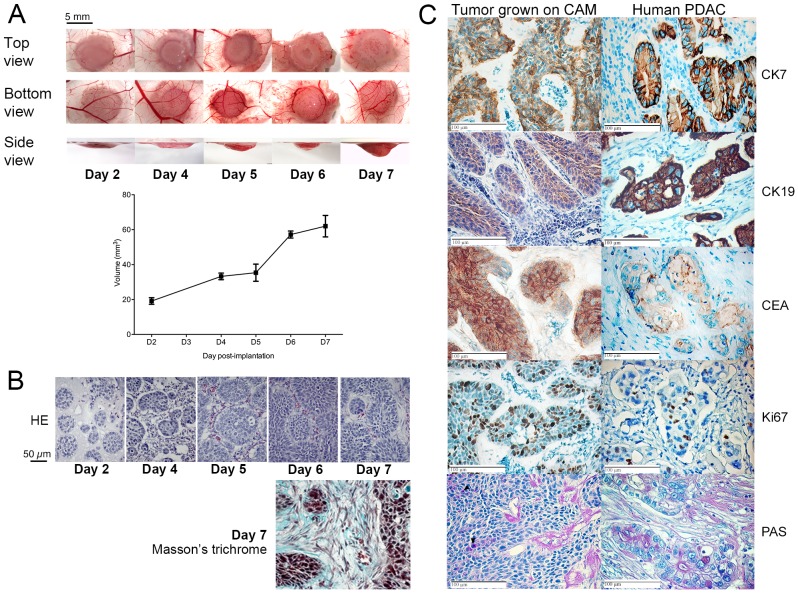
Growth curve and immunohistologic characterization of BxPC-3 tumors grown on CAM.(A) Cells were implanted on CAM at embryonic day 11 and collected 2, 4, 5, 6 or 7 days after implantation. Macroscopic pictures were obtained at the same magnification from top, bottom and side view. Results are expressed as mean ± s.d., n>5 at each time-point. (B) Histologic (Haematoxylin-Eosin or Masson’s trichrome staining) analysis of tumors collected 2, 4, 5, 6 or 7 days after implantation. (C) Immunohistology of tumors 7 days after BxPC-3 implantation on CAM and human PDAC tumors. CK7  =  Cytokeratin-7, CK19  =  cytokeratin-19, CEA  =  Carcinoembryonic antigen, PAS  =  Amylase-periodic acid Schiff staining.